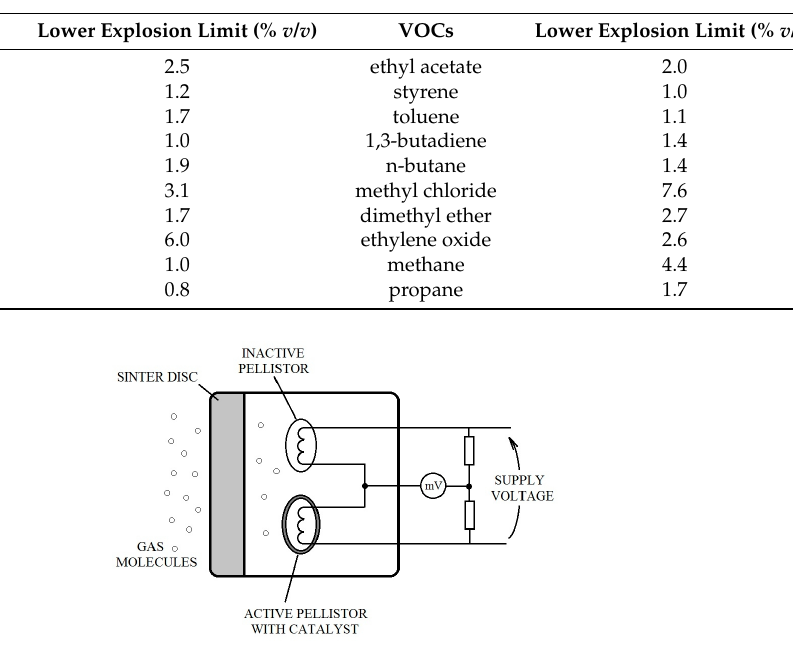
Figure 5. Scheme of NDIR-type sensor.